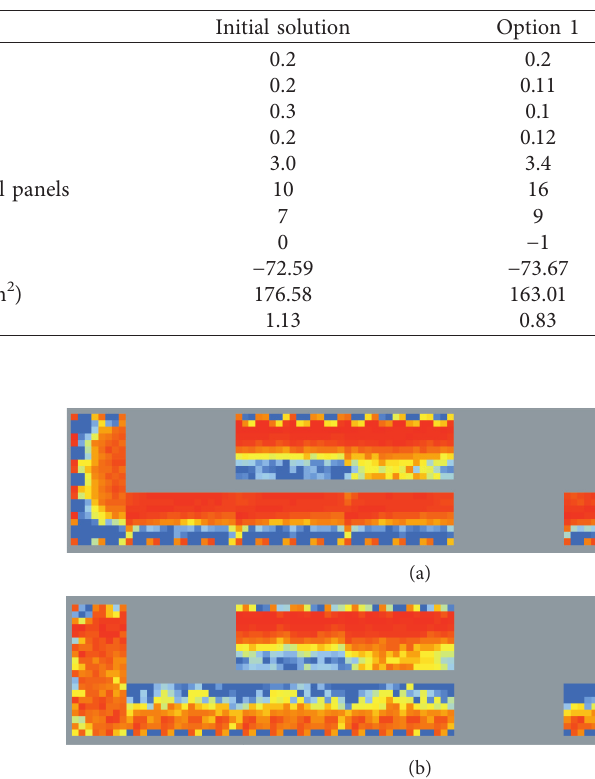
Table 8: Comparative analysis of Pareto optimal solutions and initial solution.